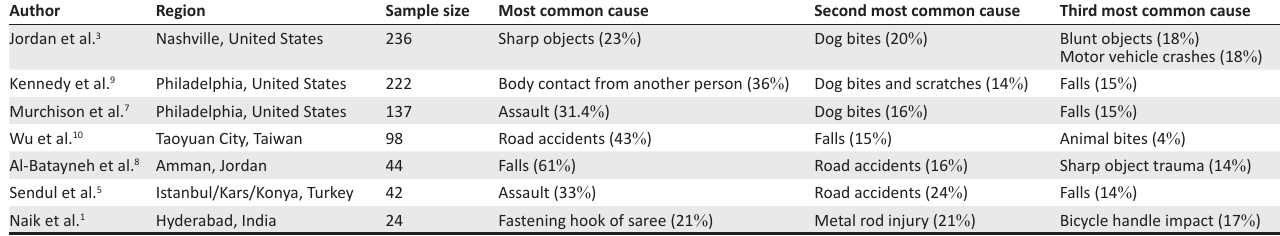
TABLE 1: Causes of canalicular lacerations in other